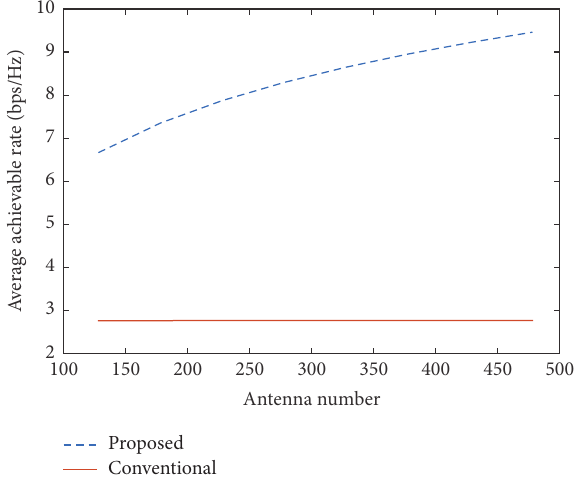
Figure 5: Average achievable rate comparison versus antenna number ( 𝑇 = 15, 𝐷 = 3, 𝐾 = 3, 𝑆𝑁𝑅 = 30 dB, and Nc =